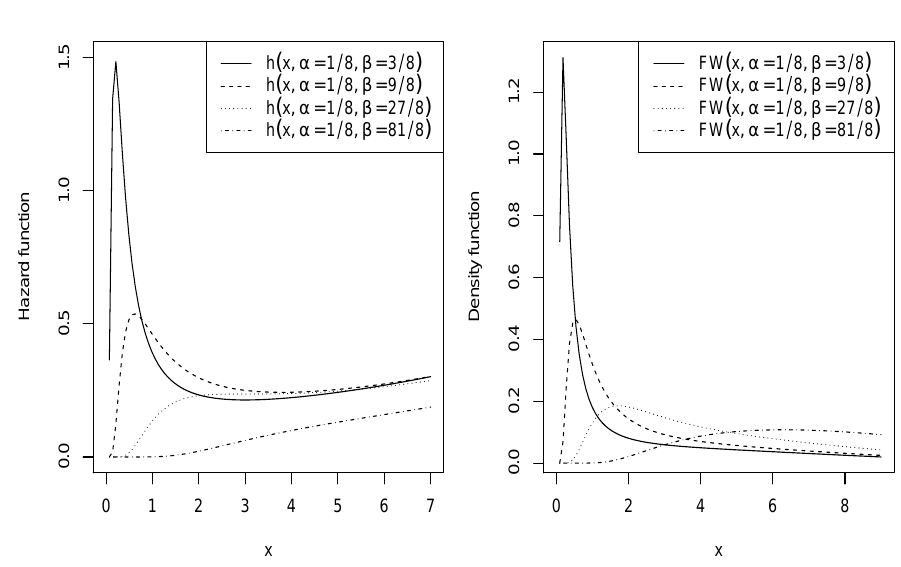
Figure 1 – The pdf and hazard function of flexible Weibull distribution (Bebbington et al. , 2007).